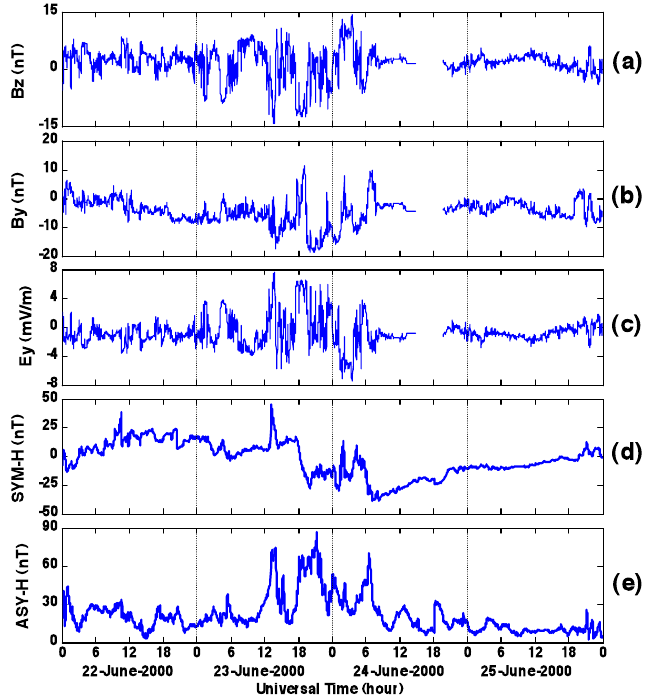
Figure 1. Interplanetary and geomagnetic conditions for the period of June 22-25, 2000. (a) IMF B the interplanetary electric field, E